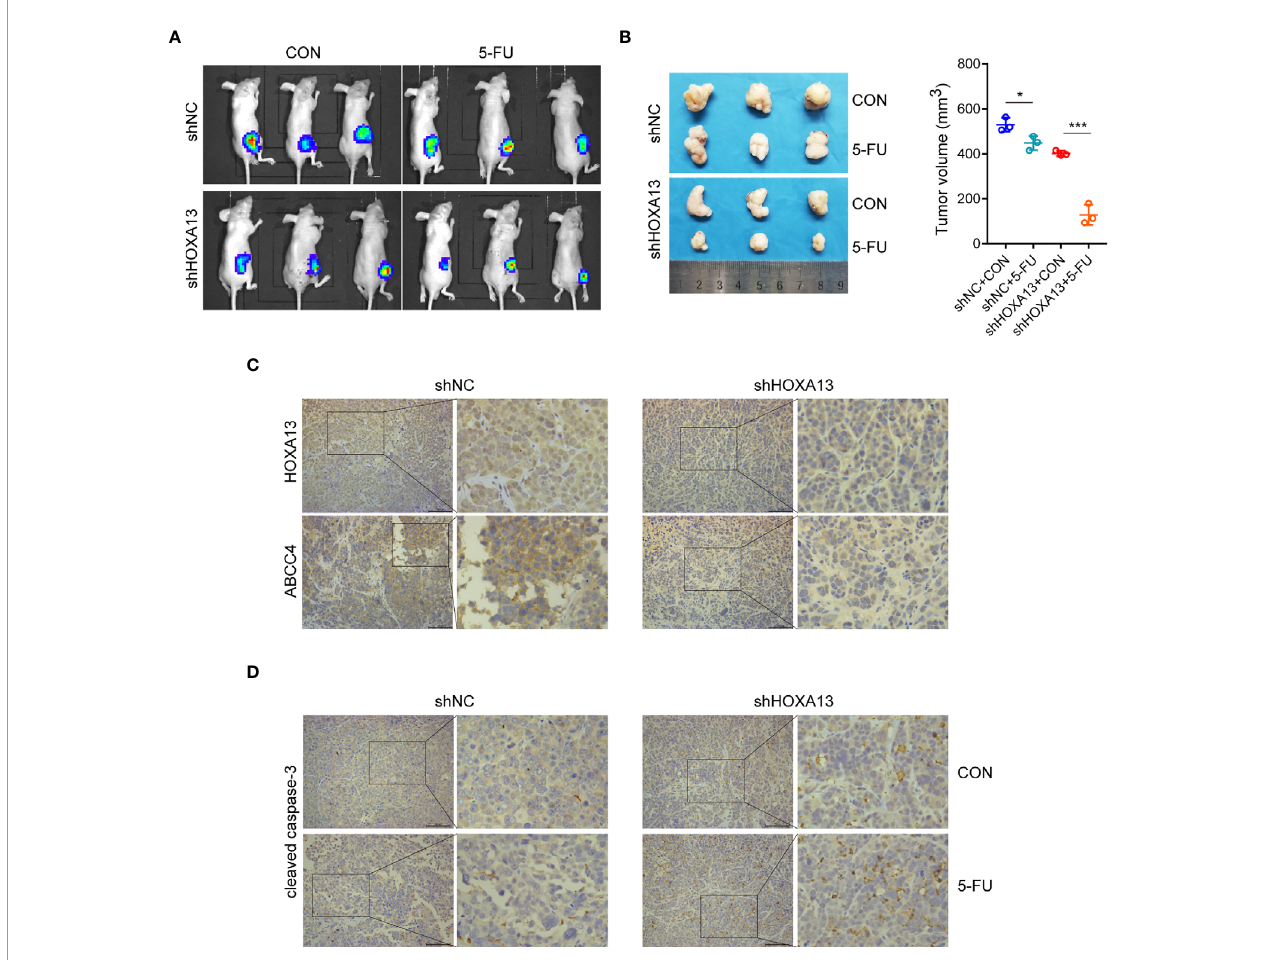
FIGURE 6 | HOXA13 knockdown increases sensitivity of GC cells to 5-FU in vivo . (A) Bioluminescence images of tumors formed by subcutaneously injecting MKN45 cells, followed by 5-FU or control (CON) treatment. (B) The fi nal tumor volumes in each group were measured. (C) IHC staining of HOXA13 and ABCC4 were performed in tumor tissues. (D) IHC staining of cleaved caspase-3 was obvious in shHOXA13 + 5-FU group. Magni fi cation ×200. * P < 0.05, *** P <